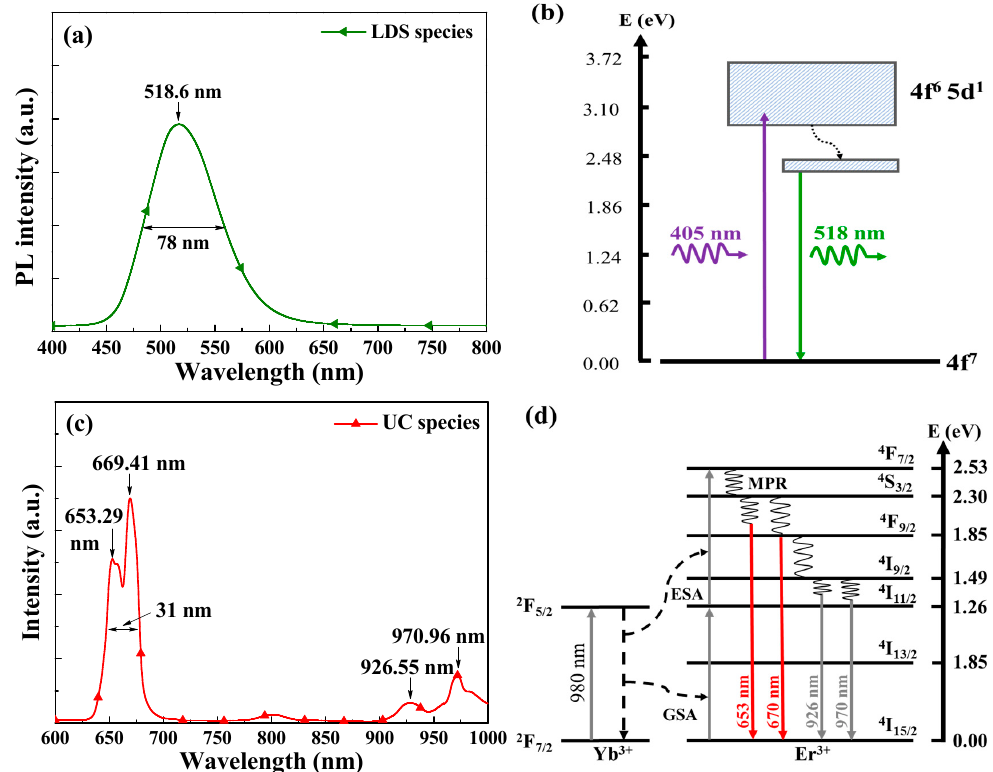
Figure 6. ( a , c ) PL fluorescence emission spectrum and ( b , d ) the energy level scheme from silicon substrate coated with a SiO 2 layer containing of Eu-doped silicate phosphors under excitation at a wavelength of 405 nm and Yb/Er-doped phosphors under excitation at a wavelength of 980 nm, respectively.